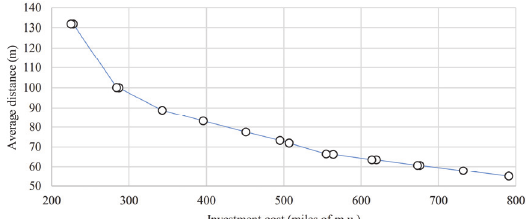
Fig. 2. Pareto front of the first scenario. Number of grid points = 20. Multi-objective approach = AUGMECON2